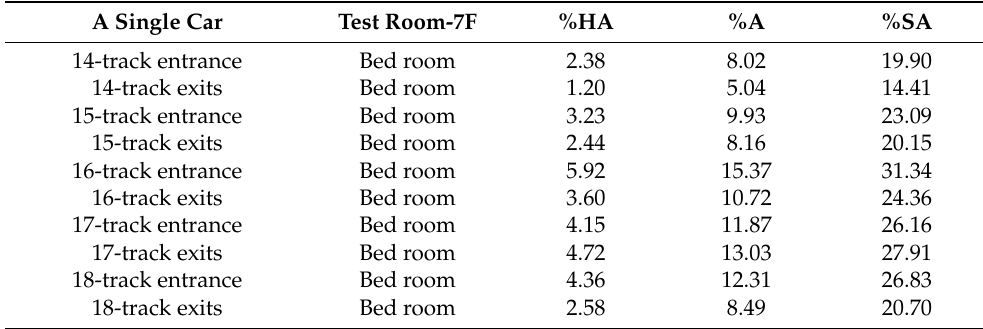
Table 11. Vibration annoyance rate of the seventh-floor test room during a single-train